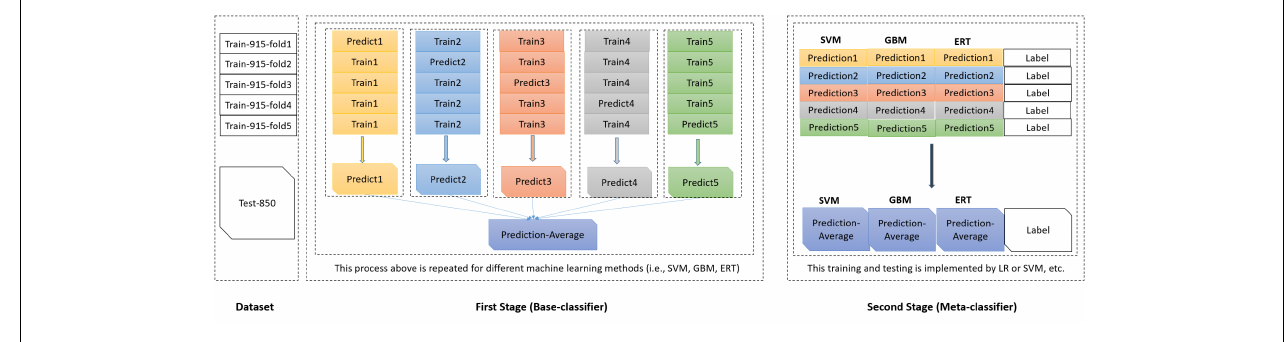
FIGURE 2 | The framework of the stacked ensemble scheme proposed in PredT4SE-Stack. TABLE 1 | Performance comparison of eight types of base-classifiers in the first stage on Train-915 dataset using 5-fold cross